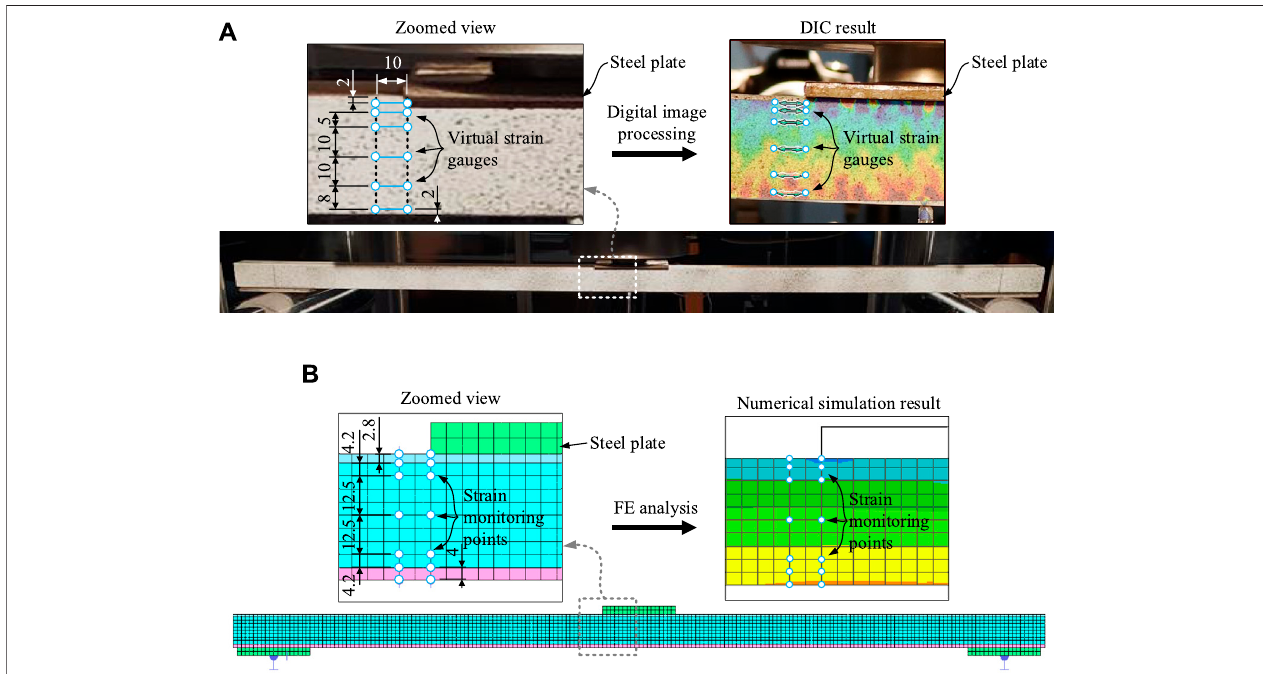
FIGURE 14 | Local strains of U GIRA pro fi le: (A) Digital image correlation system; (B) Finite element analysis.